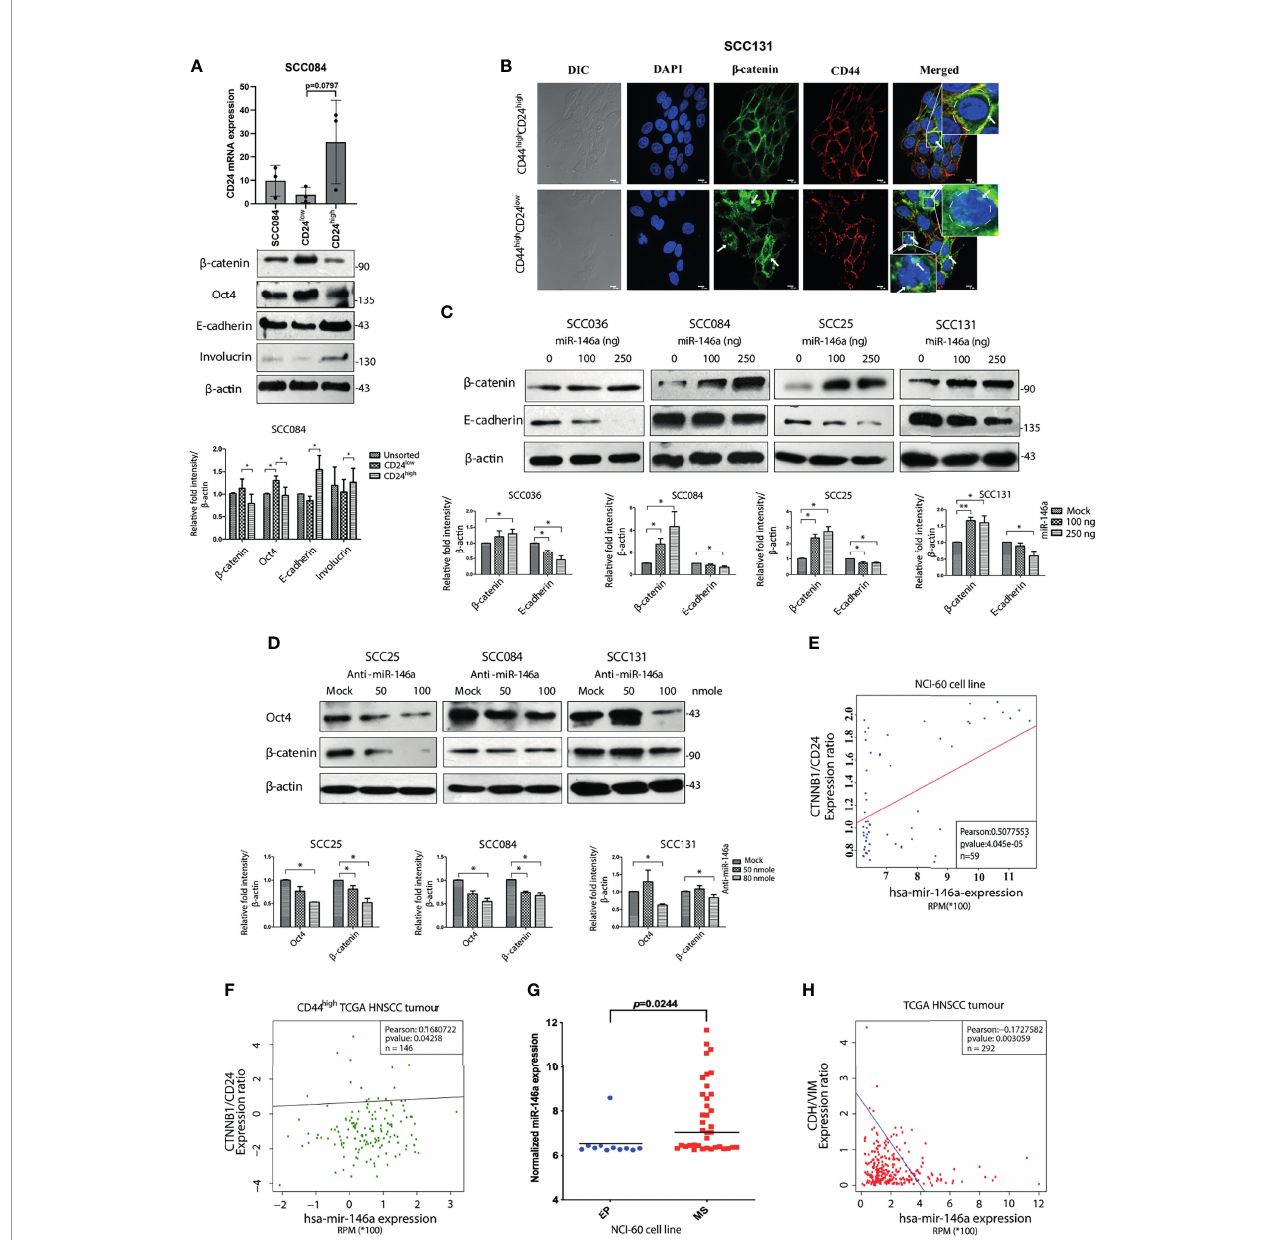
FIGURE 3 | MiR-146a induced b -catenin/Wnt Signaling in CD44 high CD24 low population. (A) Validation of CD24 low and CD24 high cells from SCC084, as shown by qRT-PCR of CD24 (unpaired t-test on delCT values). 18srRNA served as an endogenous control. Western blot images of b -catenin, Oct-4, E-cadherin and Involucrin in the respective populations along with its quantitative plot indicating the statistical data. (B) Representative confocal immuno fl uorescence images (60X magni fi cation) of CD44 high CD24 high and CD44 high CD24 low subpopulation of SCC131 showing b -catenin (green) and CD44 (red) counterstained with DAPI (blue) (scale bar equal to 10 µm). Enlarged image is shown in inset. (C) Each of the SCC cell lines were subjected to western blot analysis of b -catenin and E-cadherin upon increasing doses of miR-146a. (D) b -catenin and Oct-4 immunoblotting upon increasing doses of anti-miR-146a. Data normalized with b -actin. All the data has been graphically represented beneath the respective fi gures (*P < 0.05, **P < 0.01, ***P < 0.001). (E) Association of miR-146a expression with b -catenin/CD24 in the NCI-60 cell lines (n = 59) and (F) with b -catenin/CD24 ratio in the CD44 high tumors of the TCGA HNSCC patients (n = 146). Statistical signi fi cance was determined by Pearson correlation test. Pearson correlation coef fi cient is shown in each plot. (G) Box plots showing miR-146a expression in NCI-60 cell lines classi fi ed as epithelial (EP) and mesenchymal (MS) subgroups. p value has been calculated using mann-whitney ’ s u-test using GraphPad prism 8. (H) Correlation (Pearson) of miR-146a with CDH1/VIM expression ratio based on the RNA-Seq data from 292 TCGA HNSCC